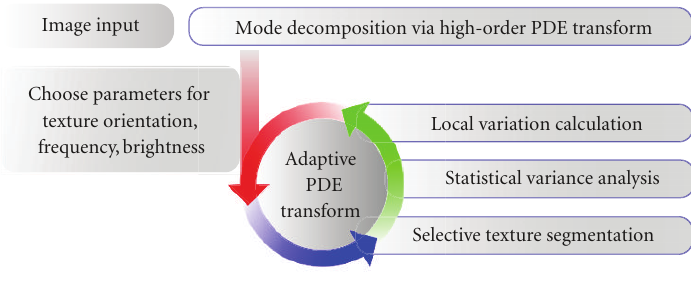
Figure 2: Algorithm of adaptive PDE transform for entangled texture